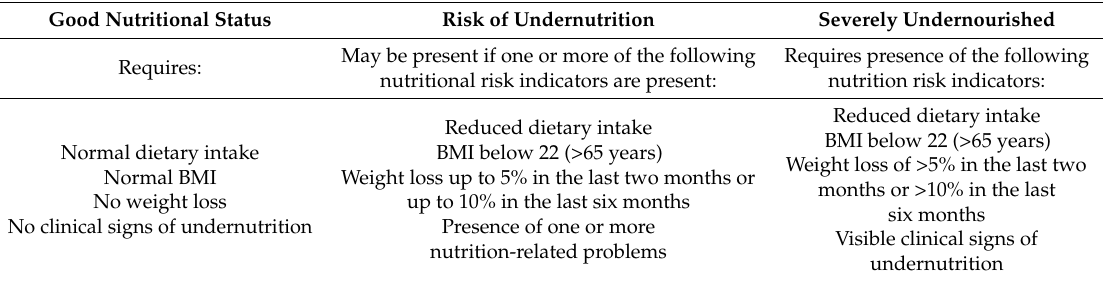
Table 2. Assessment criteria for the various nutritional status categories as specified in “The Nutrition Journal”